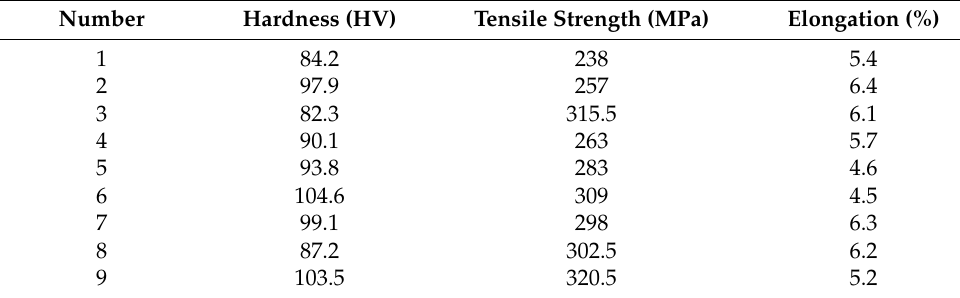
Table 3. Results of the orthogonal